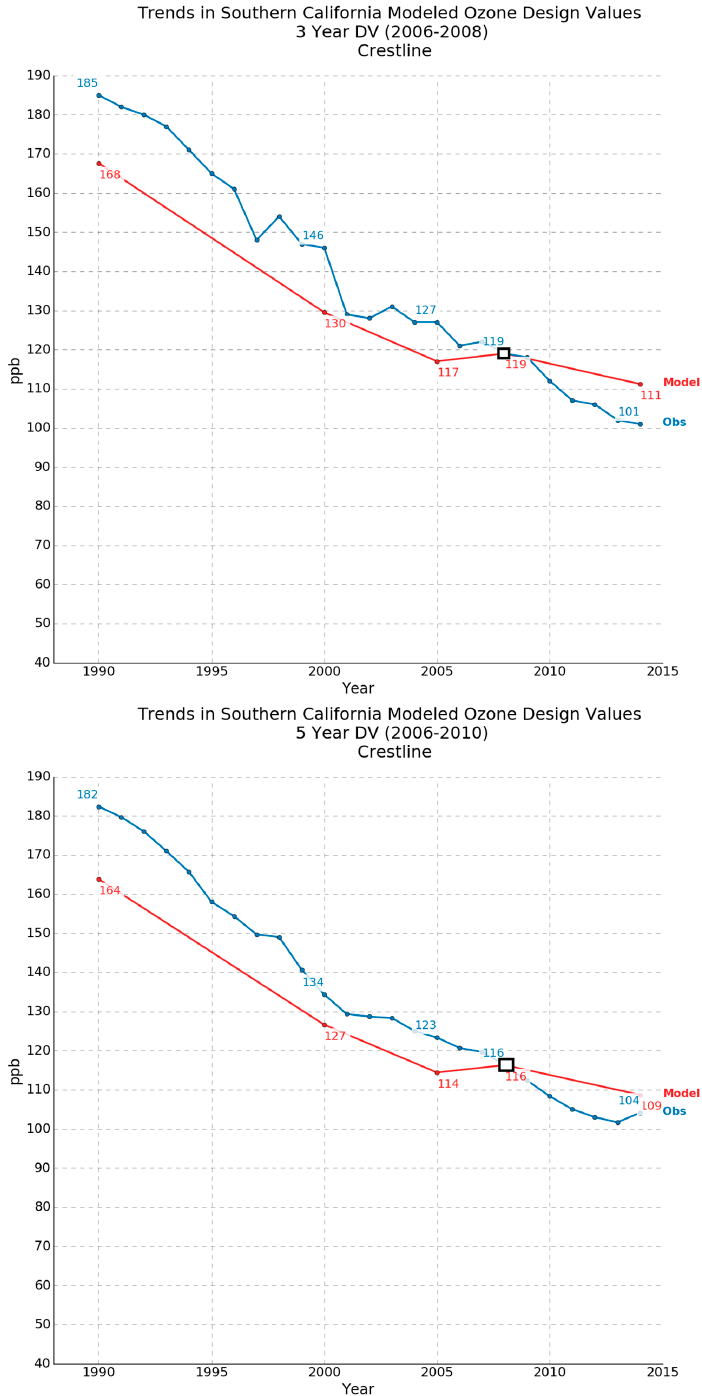
Figure 2. Modeled and observed trends in 3-year ( top ) and 5-year ( bottom ) ozone design values at the Crestline monitor from 1990 to 2014 using the 2012 AQMP modeling database. The anchor (baseline) year for the design value calculations is 2008 (marked by the square symbol in the figures).